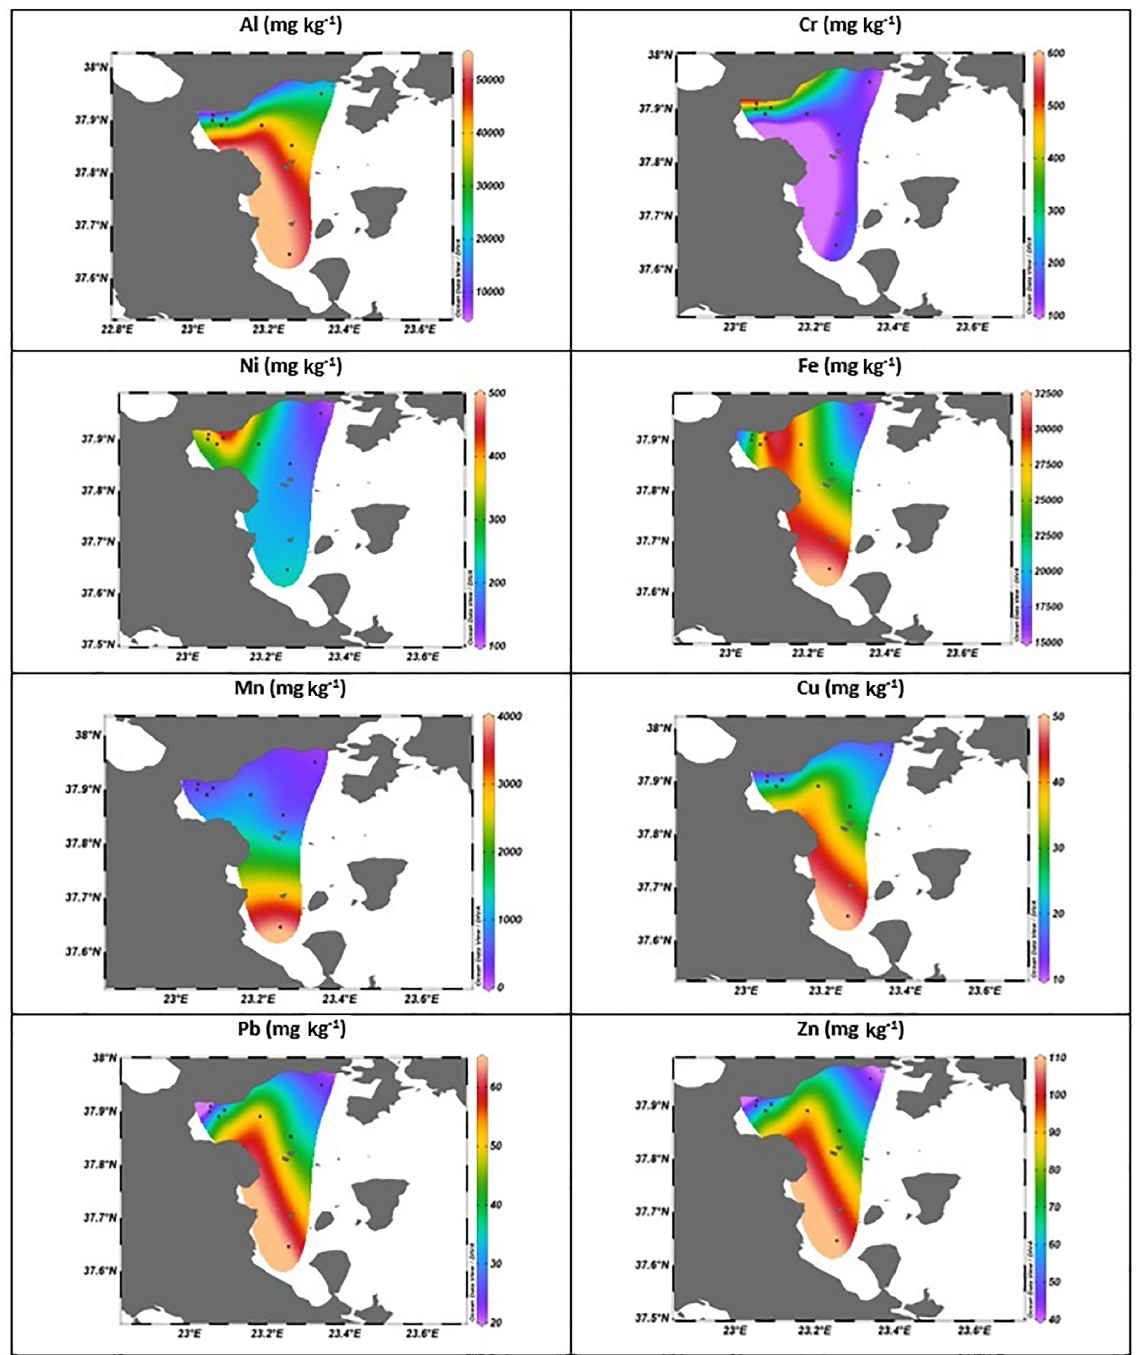
Figure 5. The horizontal distributions of heavy metals in the surface sediments of the western Saronikos Gulf. In cases with coarse surface sediments at stations MOT13A, MOT16 and UN4, the concentrations of the total sediment (sand and mud) were